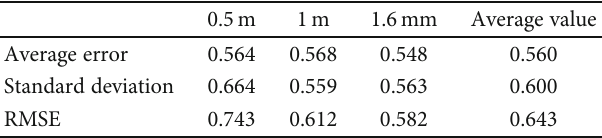
Figure 17: Line chart of error at di ff erent tubing. Table 11: Precision and accuracy at di ff erent tubing.